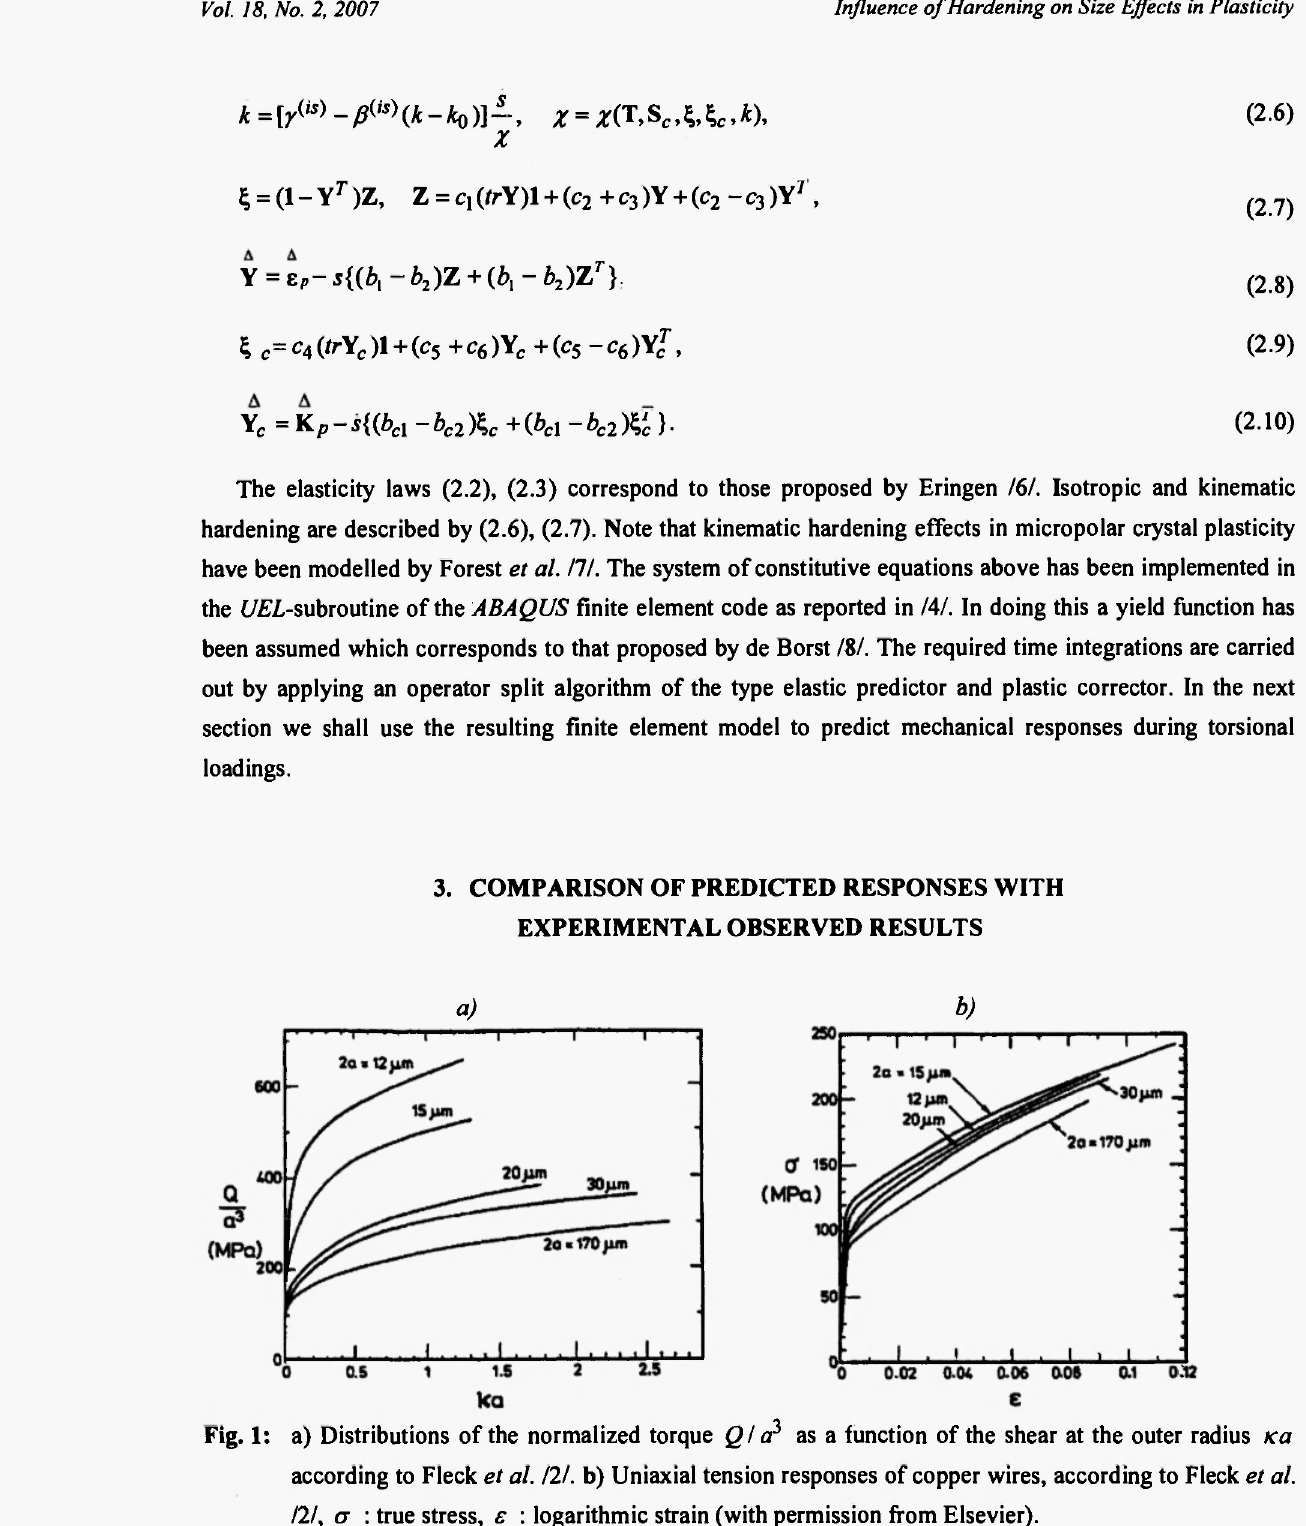
Fig. 1: a) Distributions of the normalized torque Ql a 3 as a function of the shear at the outer radius κ a according to Fleck et al. 111. b) Uniaxial tension responses of copper wires, according to Fleck et al. Ill, σ : true stress, ε : logarithmic strain (with permission from